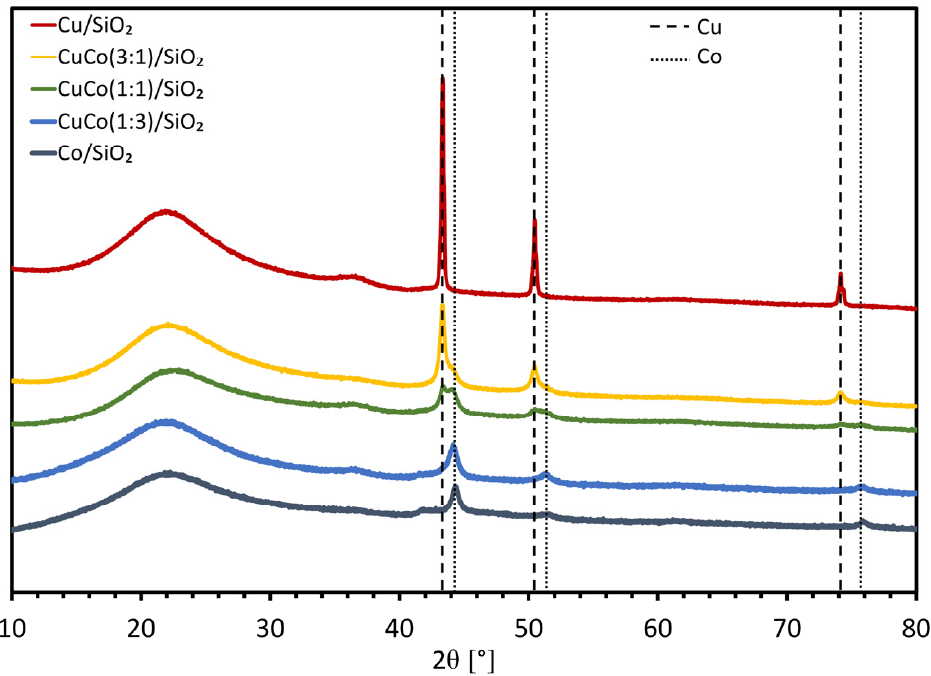
Figure 2. XRD results of CuCo/SiO 2